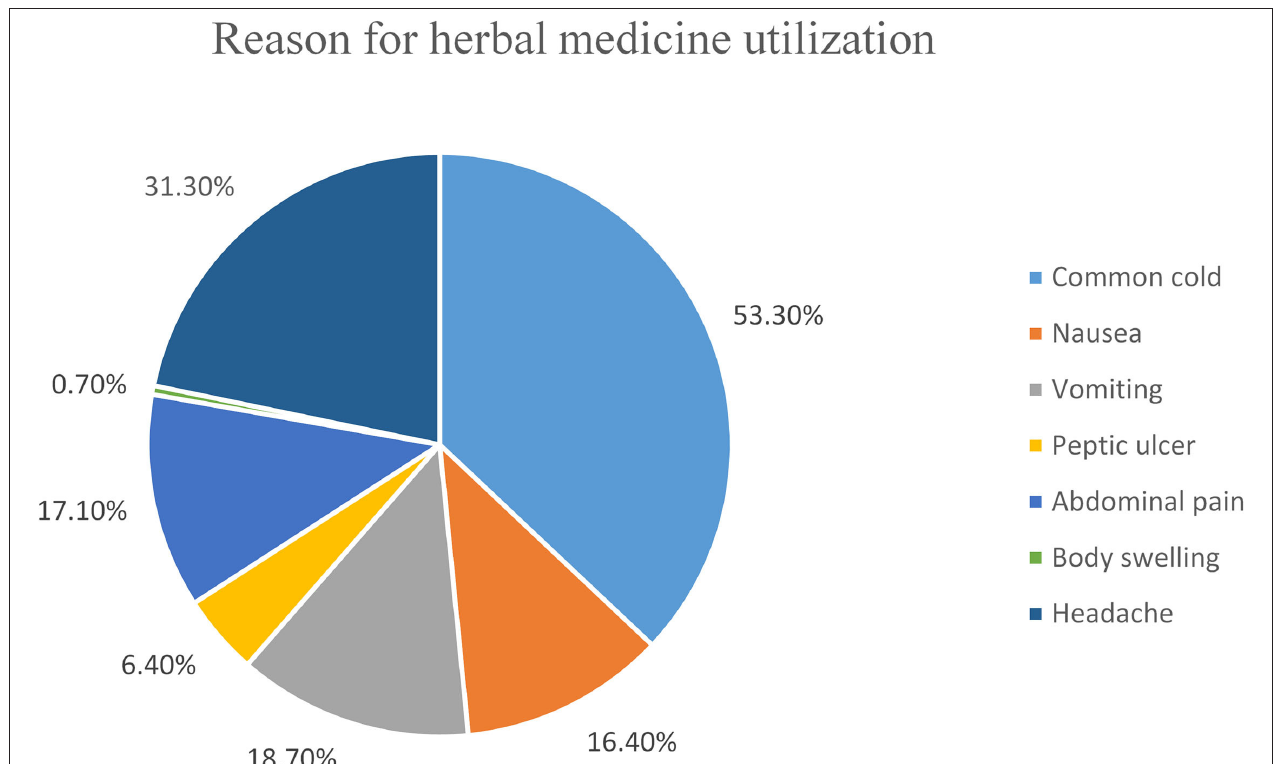
FIGURE 4 | Indications for using the herbal medicine during the current pregnancy, among mothers who visited governmental health institutions for antenatal care in Debre Behan town, Ethiopia.